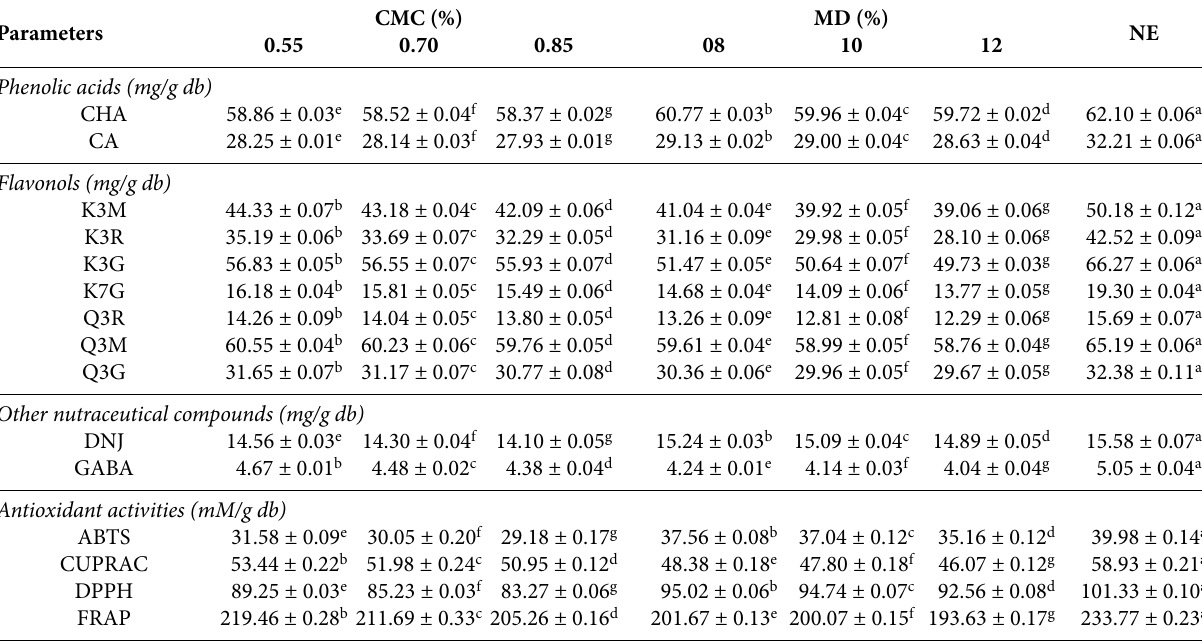
Table 1. Nutraceuticals and antioxidant properties of encapsulated freeze-dried mulberry leaf extract powders